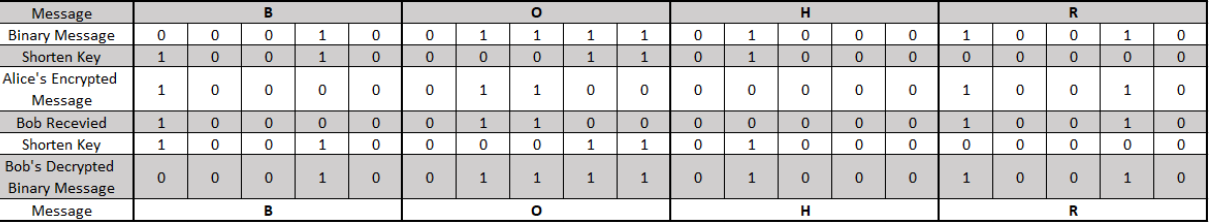
Figure 8. A 52 bit transmitted message between Alice and Bob. Table 4. A 52 bit accuracy for experiment and simulation—without Eve. 52 Bit—Without